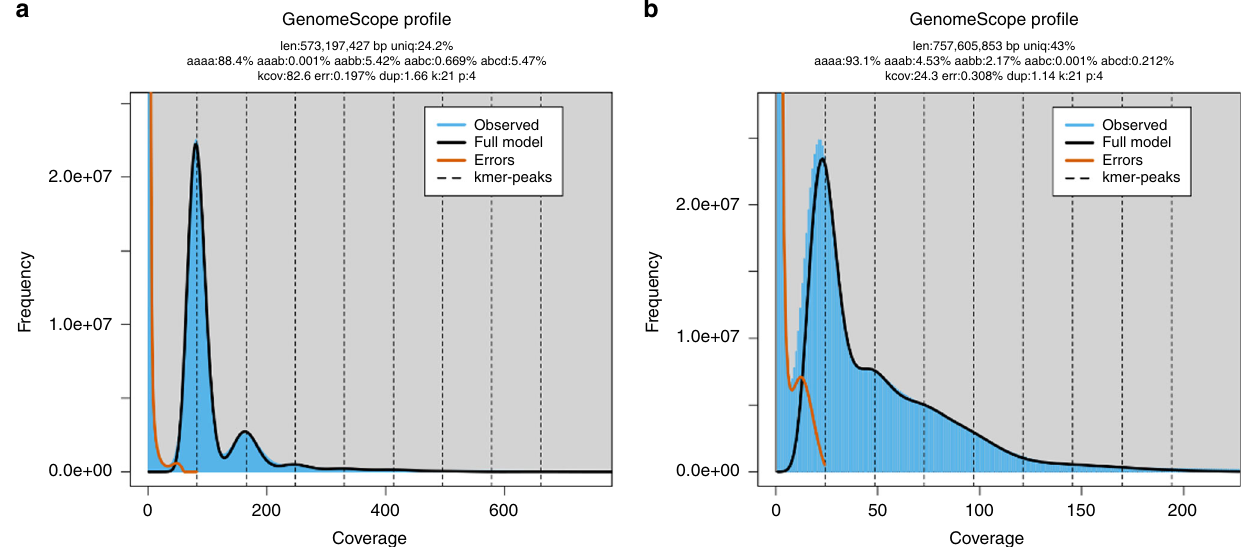
Fig. 6 Allotetraploid and autotetraploid GenomeScope plots. K-mer spectra and fi tted models for ( a ) allotetraploid Gossypium barbadense and ( b ) autotetraploid Solanum tuberosum . Note that the allotetraploid plot has aaab < aabb , while the autotetraploid plot has aaab > aabb